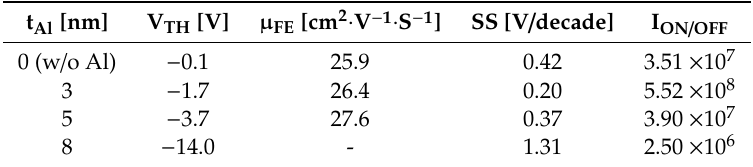
Table 1. Electrical parameters extracted from the indium–gallium–tin oxide (IGTO) thin-film transistors (TFTs) without and with 3, 5, and 8 nm thick Al capping